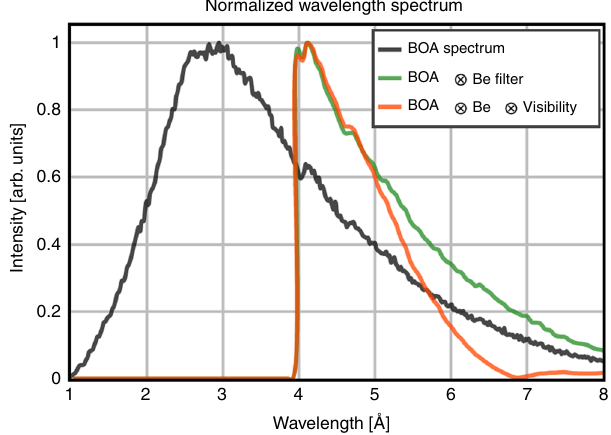
Fig. 4 Wavelength spectrum. Normalized wavelength spectrum of the BOA (Beamline for neutron Optics and other Applications) beamline (black), with the beryllium fi lter (green) and its convolution with the visibility function calculated for the polarized neutron grating interferometry (pnGI) setup used to perform the experiment